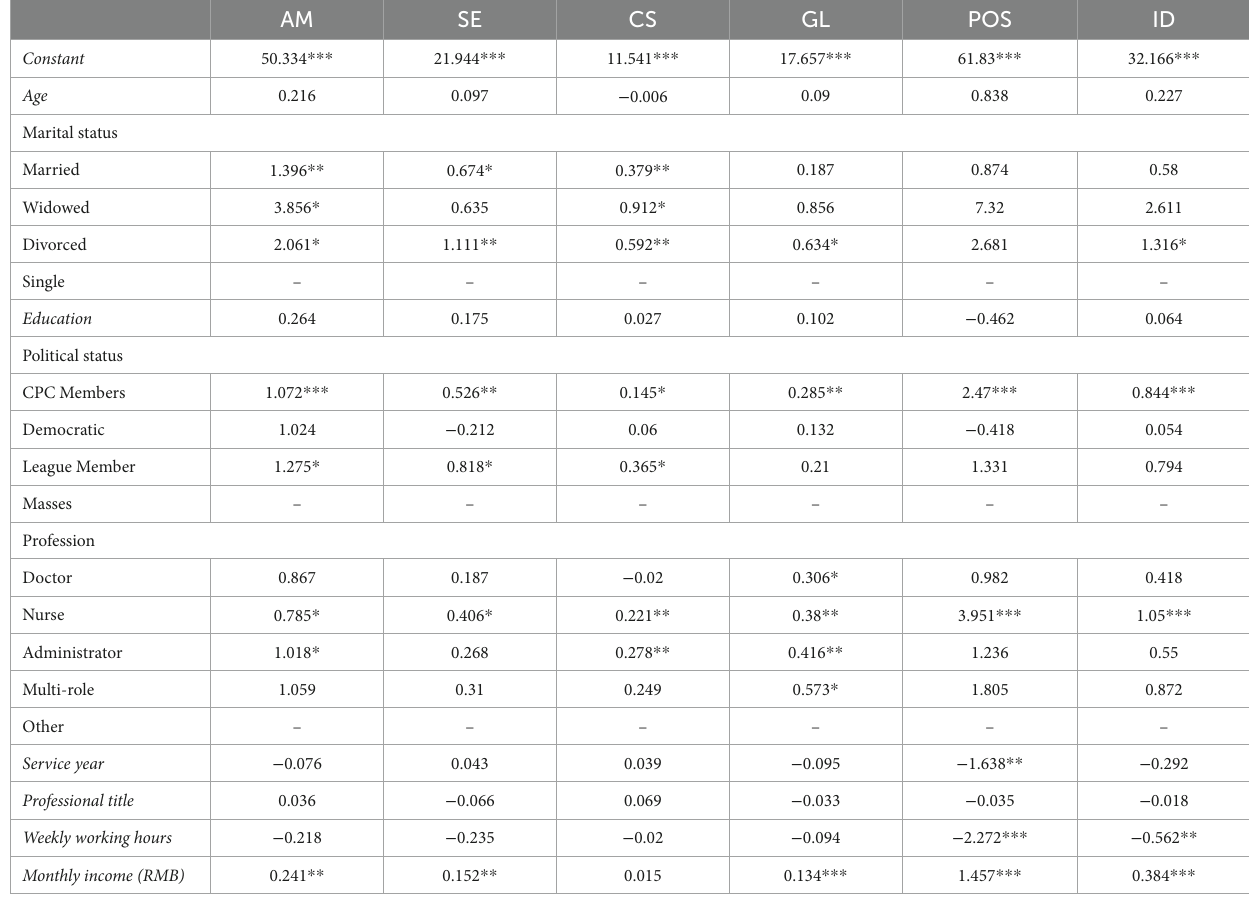
TABLE 4 Regression coefficient of intrinsic drive and its five dimensions.